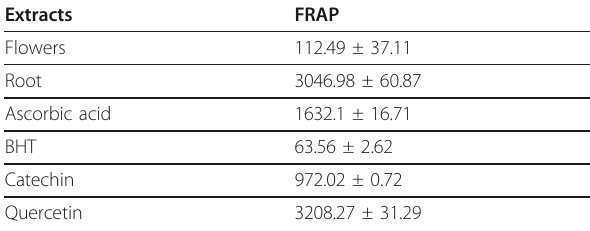
Table 2 Total antioxidant activity of the methanolic extracts of the flowers and roots of Pyrostegia